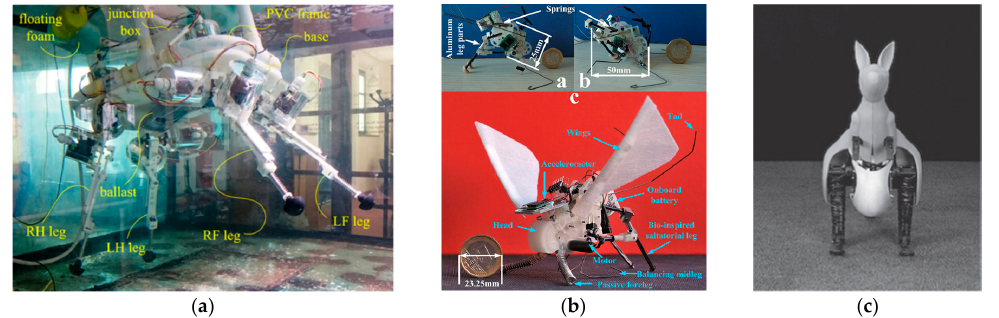
Figure 4. Examples of jumping robots: ( a ) Multi ‐ legged underwater robot [39]; ( b ) Leafhopper